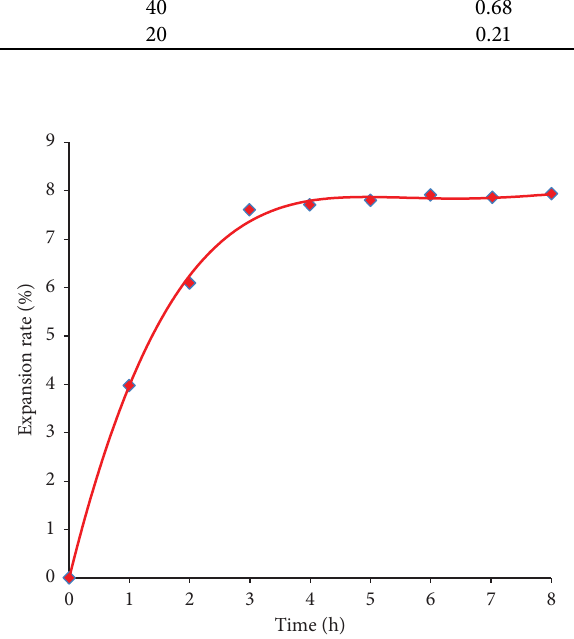
Figure 3: Reservoir rock expansion rate test with green synthesis and metal oxide composites.